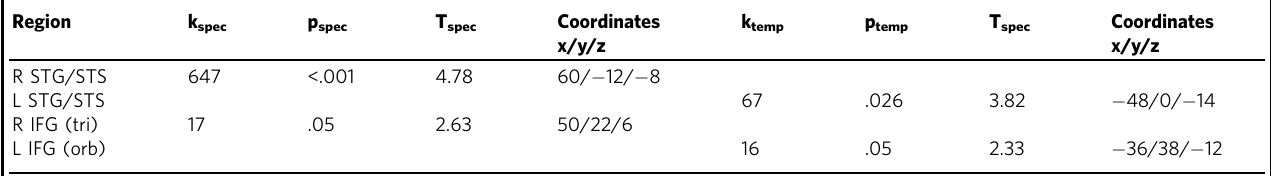
Table 2 Lateralized brain activity during speaking with spectrally (columns two to fi ve) or temporally (columns six to nine) altered feedback compared to normal speaking (conjunction over consonant and vowel perturbations), small volume corrected for multiple comparison in literature-based ROIs at p < 0.05 with a cluster de fi ning threshold of p < 0.001 (one-sided, paired t -test, n = 22 participants per